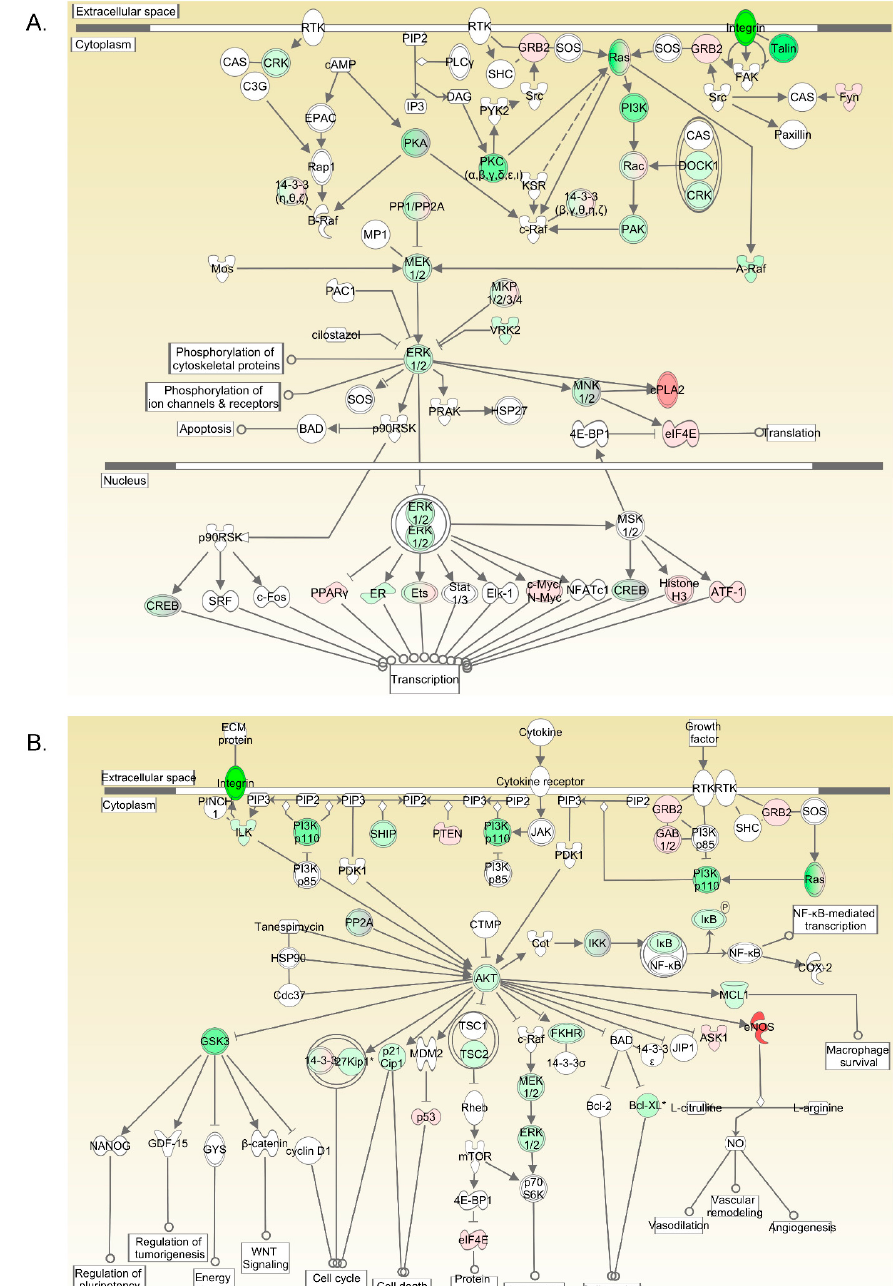
Figure 5. Pathways upregulated in the fetal carotid arteries as compared to those in adults. ( A ) The upregulation of PI3 Kinase, PKC, and ERK1/2. ( B ) The upregulation of GSK3, PI3 Kinase, AKT, and ERK1/2 pathways.